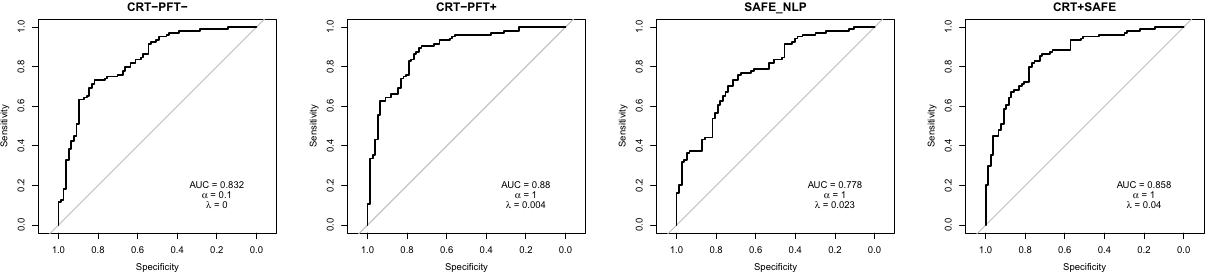
Figure 3. Receiver-operator characteristic curves to assess classification performance of model-based algorithms.